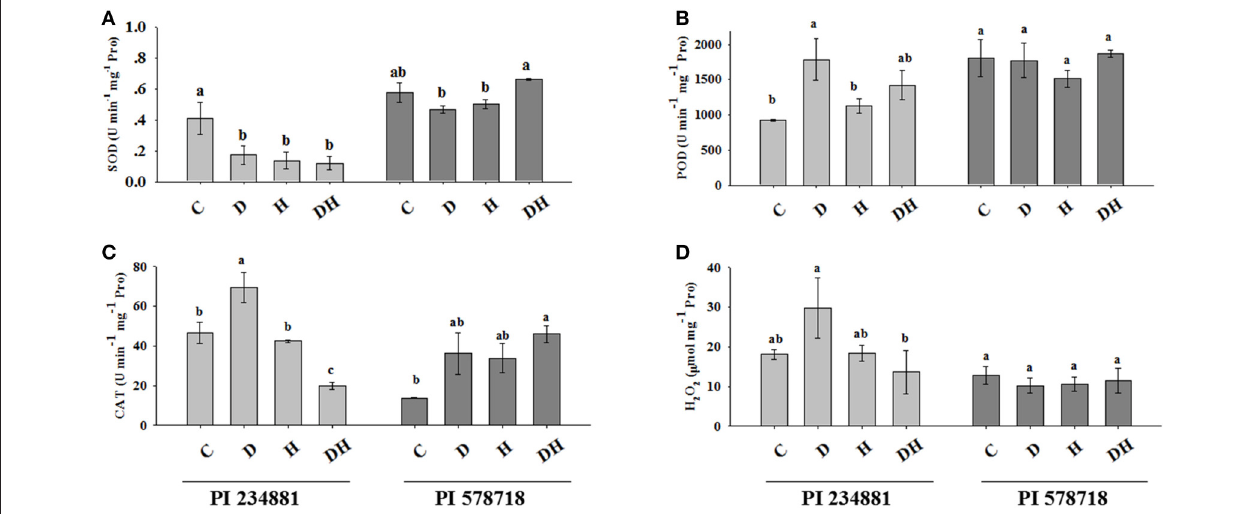
FIGURE 2 | The effects of stress treatments on SOD (A), POD (B), CAT (C) activities and H 2 O 2 (D) content in 7th leaves of PI 234881 and PI 578718 under control (C), drought (D), heat (H), combined stress (DH). Different letters indicate significant differences between treatments ( P < 0.05) based on LSD test.